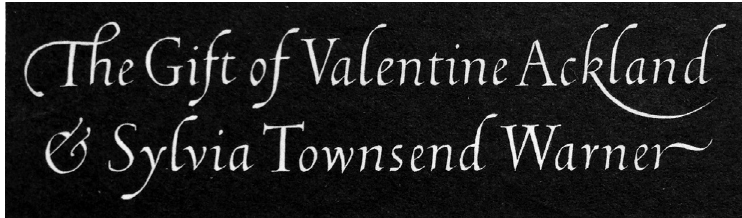
Figure 1 Bookplate in the Ackland Bequest copy of poems by Cavafy. Photograph © 2020 Liz